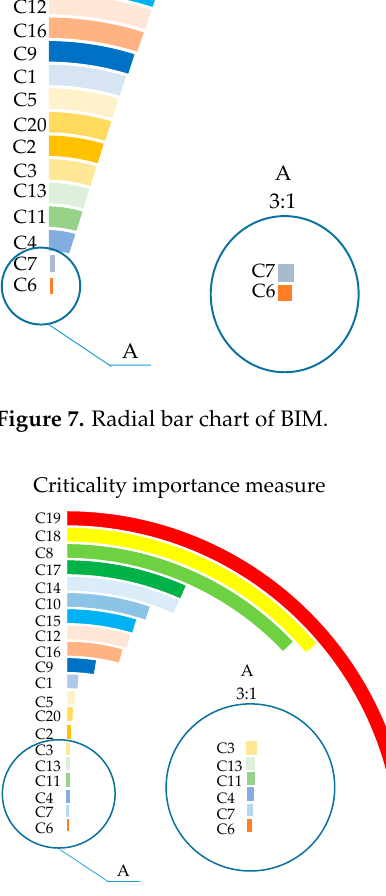
Figure 8. Radial bar chart of CIM.